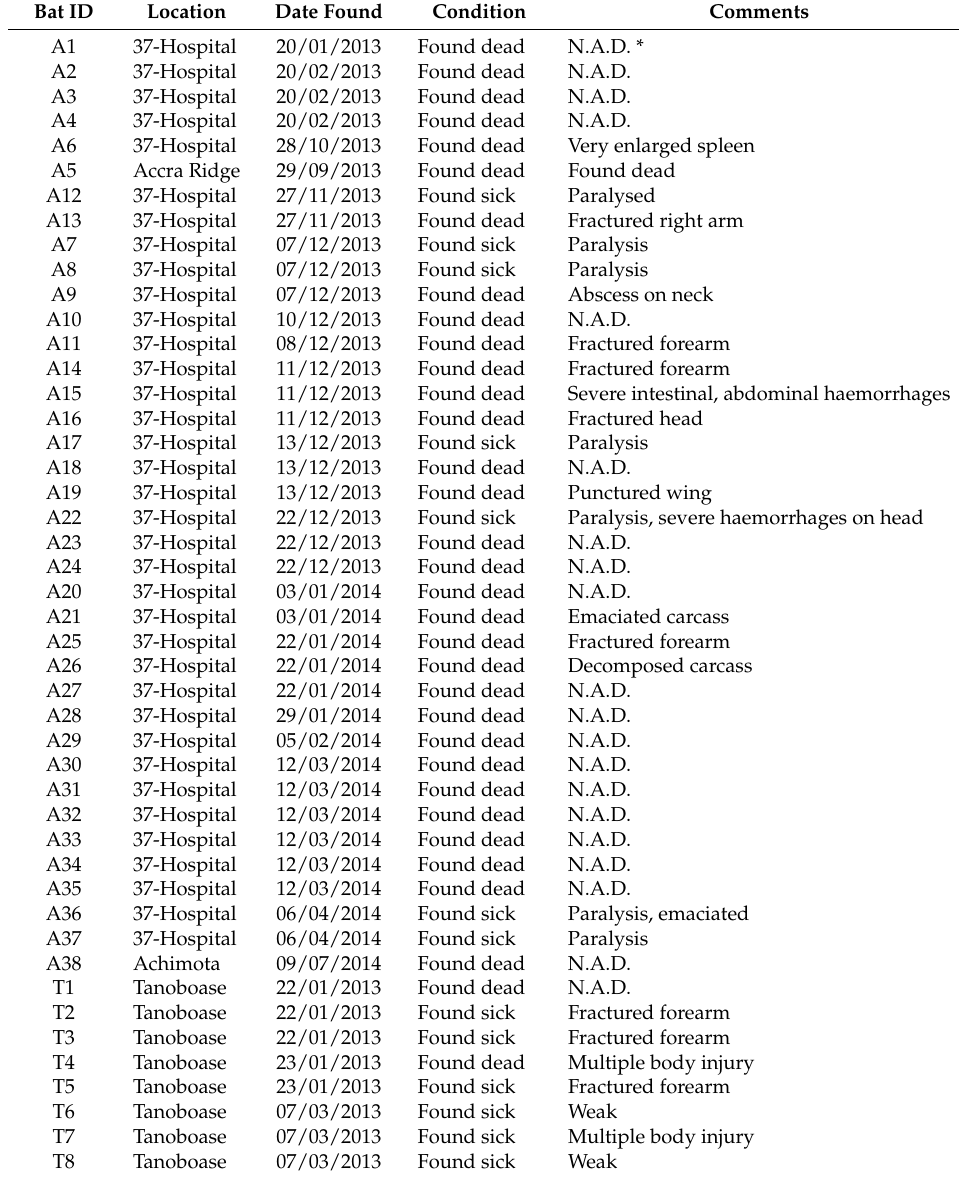
Table 4. Necropsy findings in dead/moribund E. helvum bats. All bats found sick were terminated humanely and blood taken as